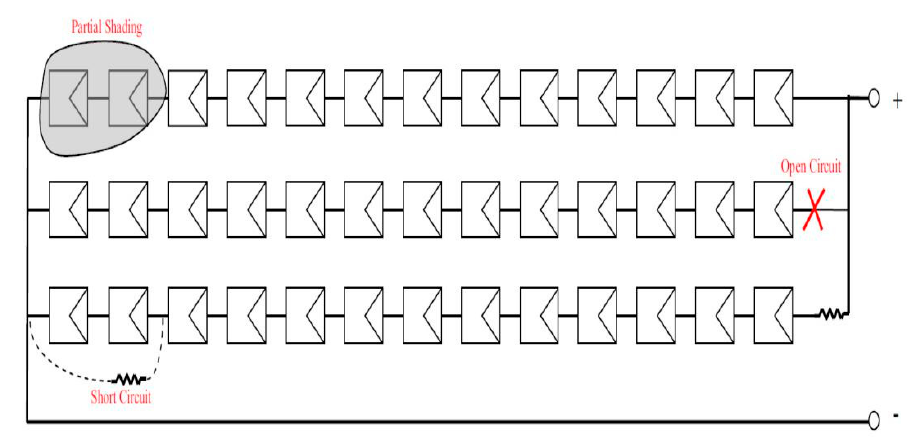
Figure 1. Simulated faults in laboratory PV array.